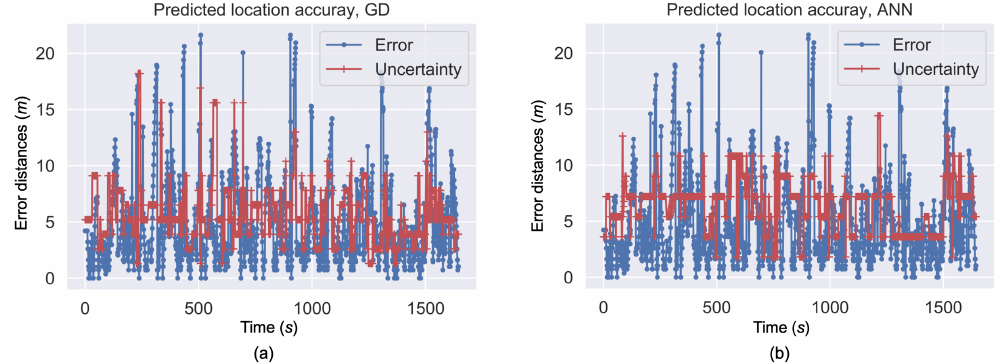
Figure 10. Predicted location uncertainty by GD ( a ) and ANN ( b ).